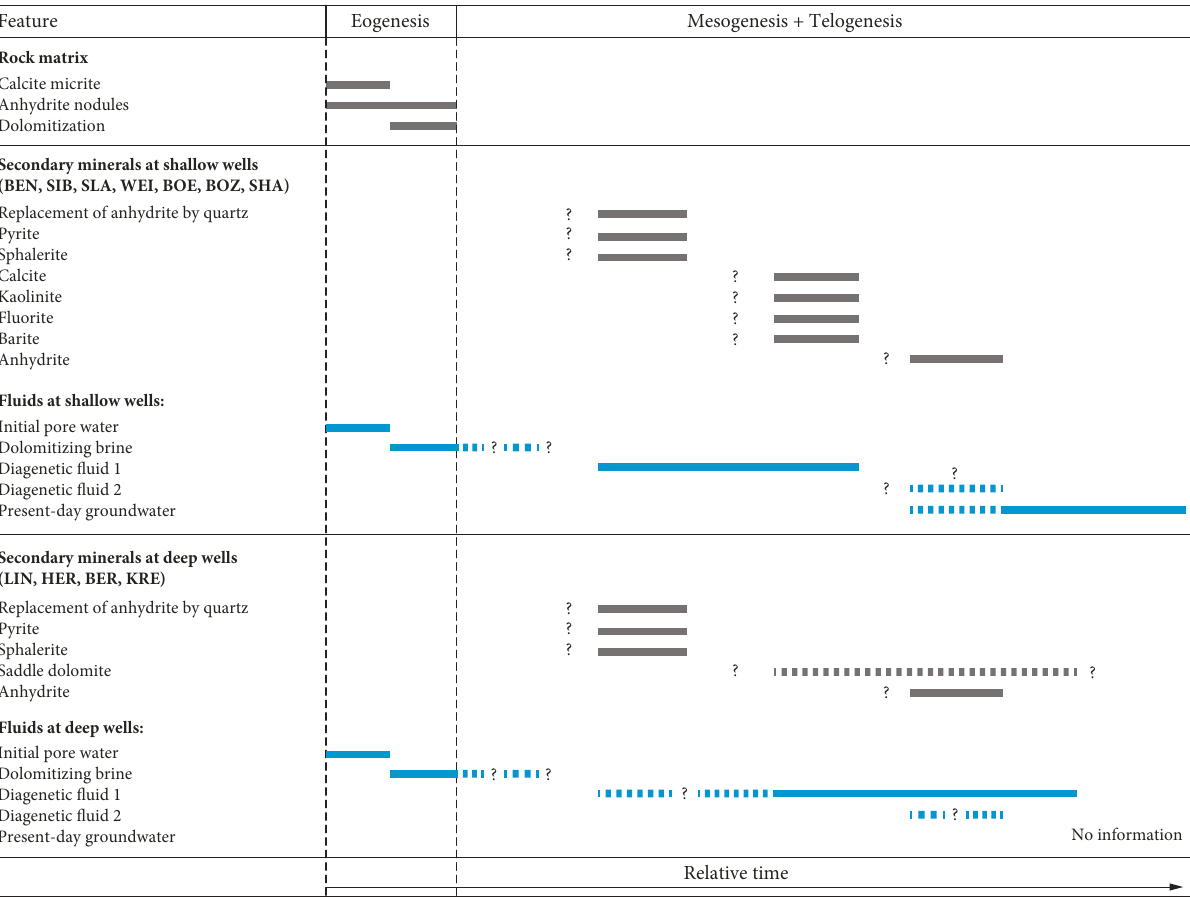
Figure 6: Paragenetic sequences of secondary minerals in dissolution cavities and fractures in the shallow wells along the northern margin of the Swiss Molasse Basin compared to those in the southern, deeper